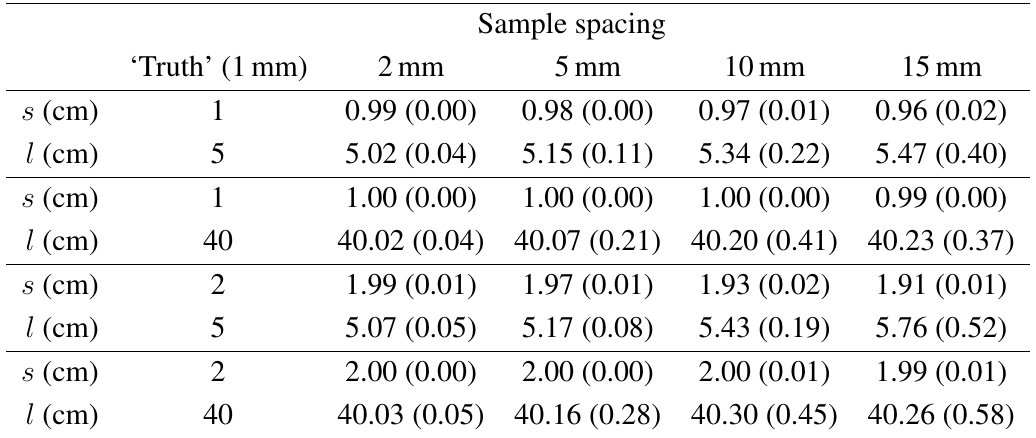
Table 2. Average values of s and l obtained for different horizontal spacings. Standard deviations are added between brackets.